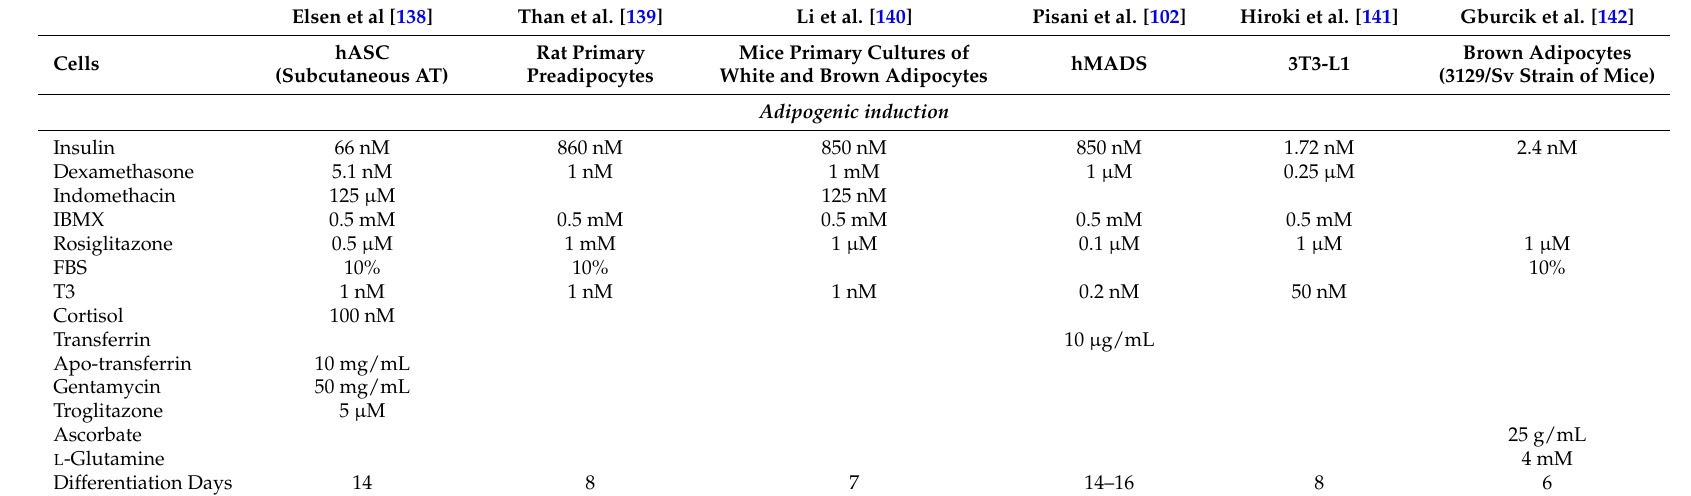
Table 2. Brown/beige adipogenic differentiation